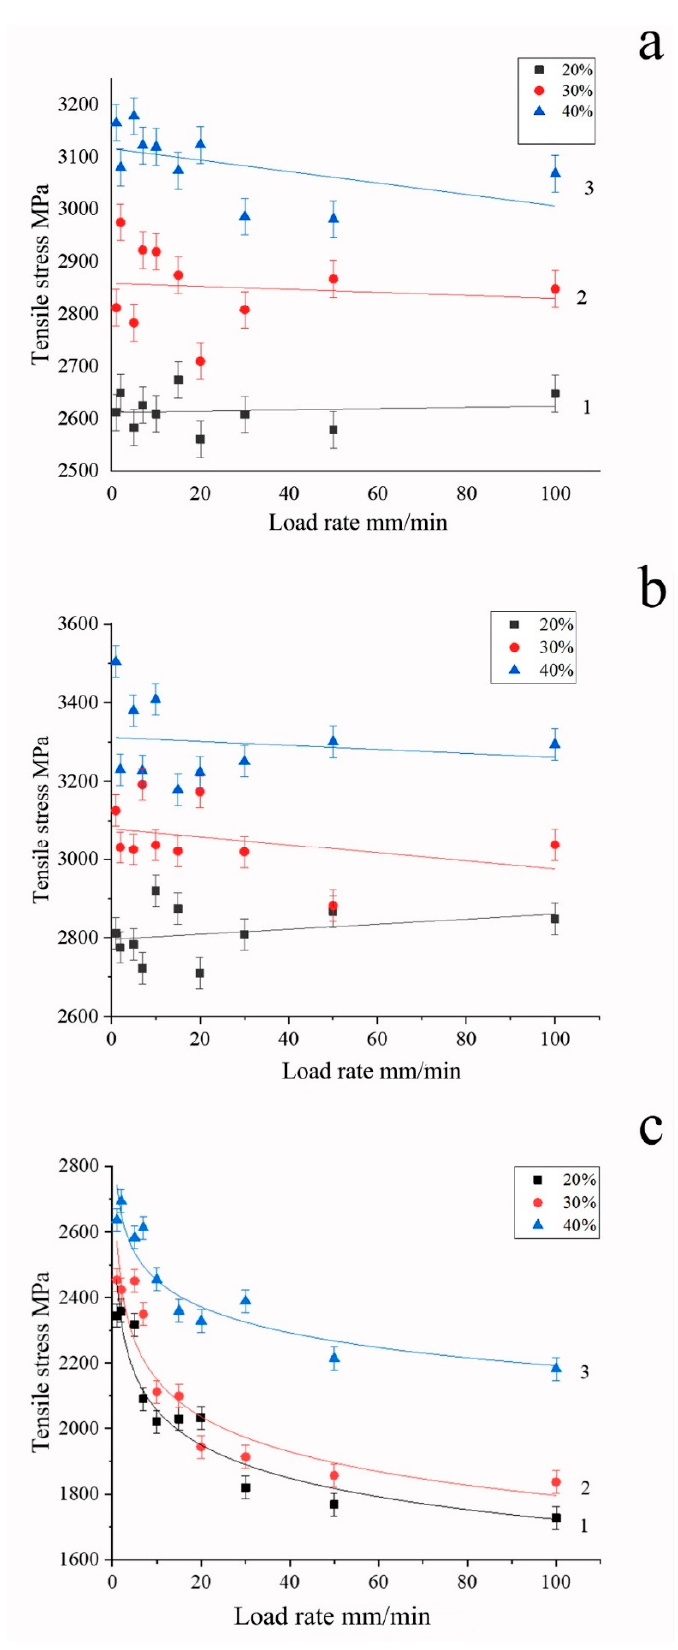
Figure 4. Dependences of the tensile strength on the loading rate for composites based on Toray T700 ( a ), UMT49 ( b ), and UMT400 ( c ) carbon fibers, polysulfone content indicated in wt. %.